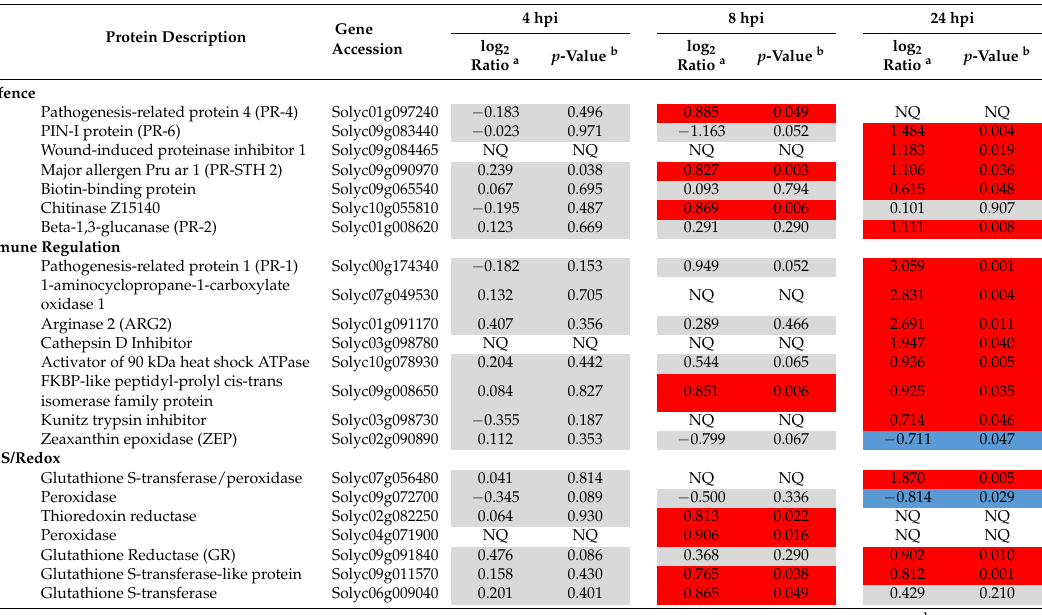
Table 1. Proteins involved in defence, immunity and ROS/redox mechanism with significant change in abundance at 4, 8, 24, hpi of Pst DC3000.